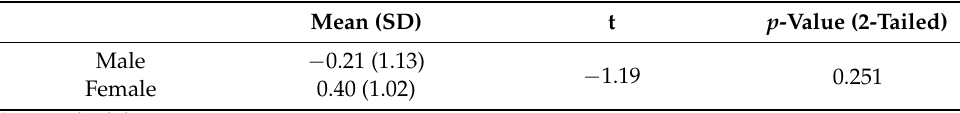
Table 5. Result of independent sample t -test.